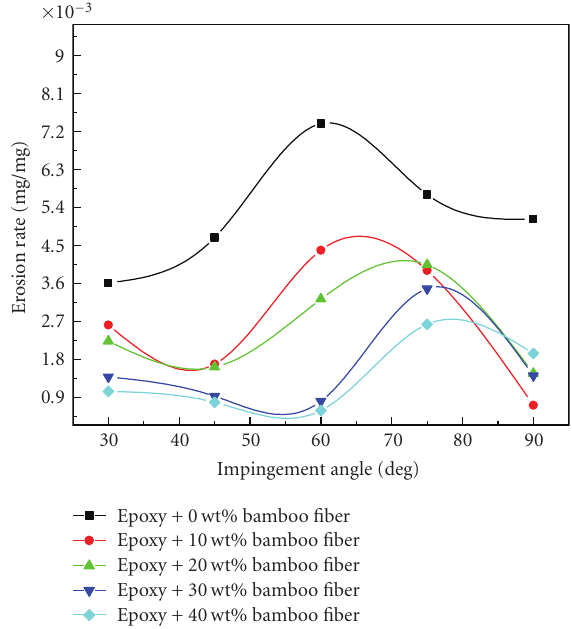
Figure 7: E ff ect of impingement angle on the erosion wear rate of the